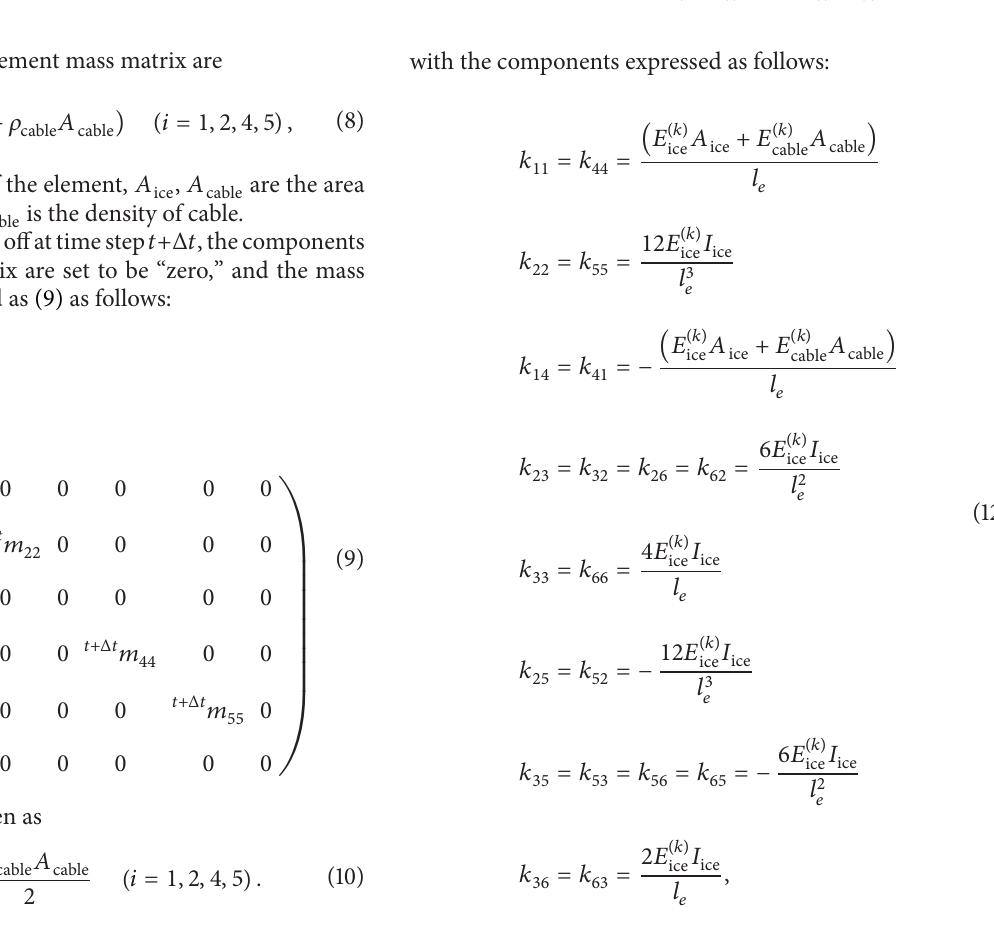
Figure 2: FE models before and after ice